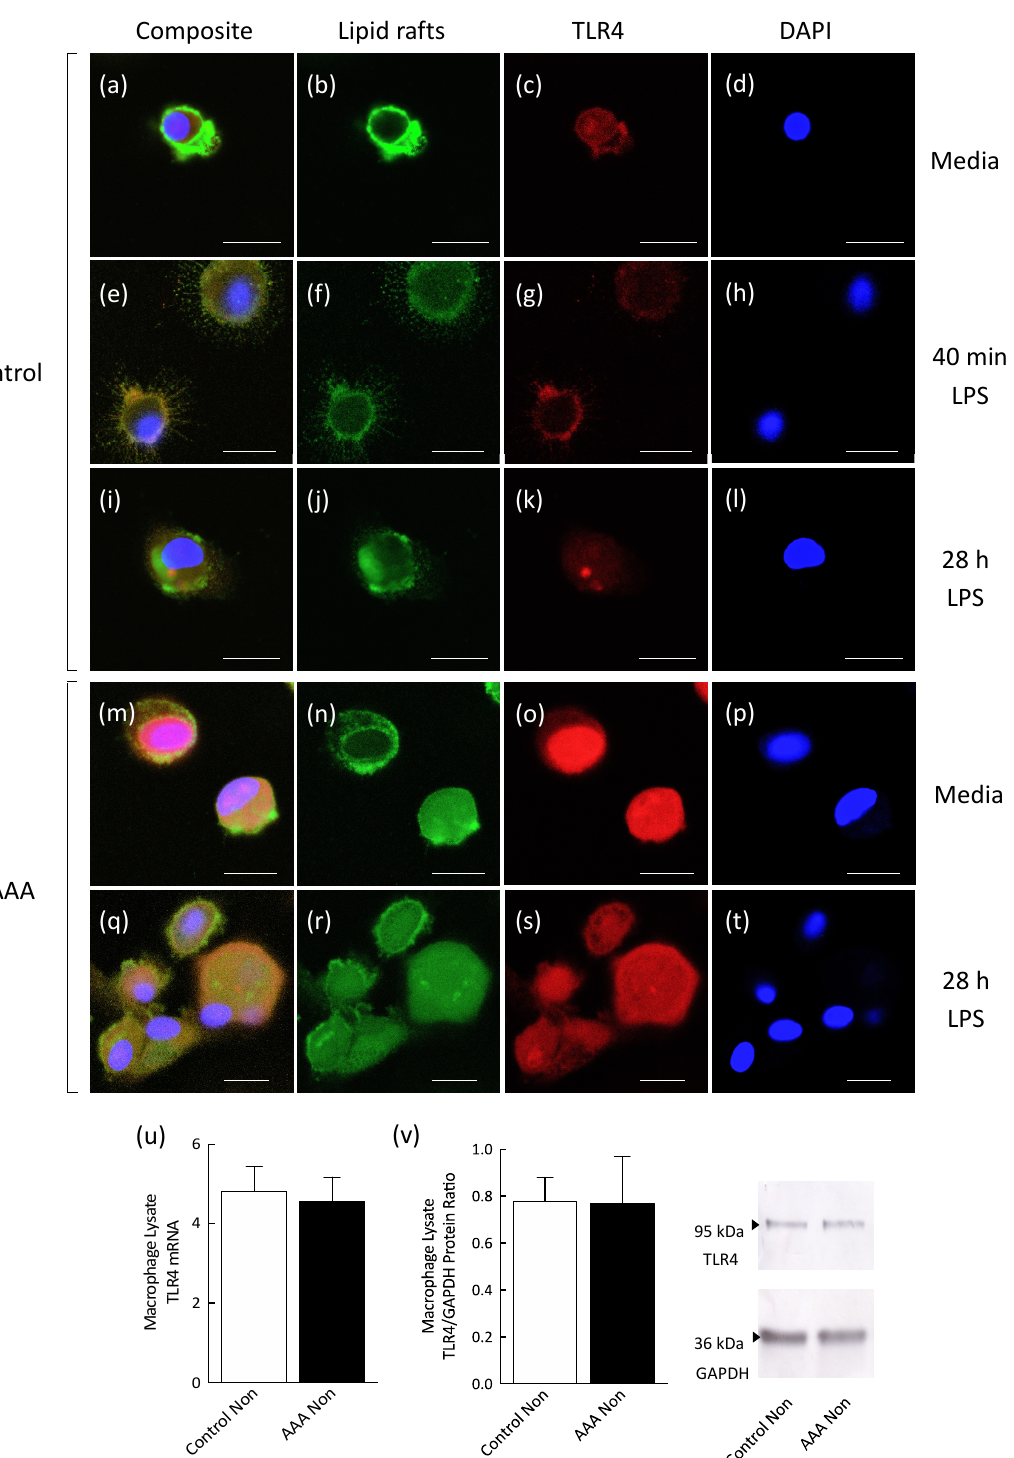
Figure 4. Representative images showing di ff erential distribution of lipid rafts and TLR4 in human monocyte-derived macrophages before (control, a – d ; AAA, m – p ) and after 40 min LPS stimulation (control, e – h ) or 28 h LPS stimulation (control, i – l ; AAA, q – t ). Lipid rafts were localized to the membrane of non-stimulated ( a , b ) and 40 min LPS-stimulated macrophages from n = 8 / 8 control participants ( e , f ) and lipid raft internalization was observed in n = 8 / 8 control participant macrophages following 28 h LPS stimulation ( i , j ). Lipid rafts were internalized in macrophages from n = 7 / 10